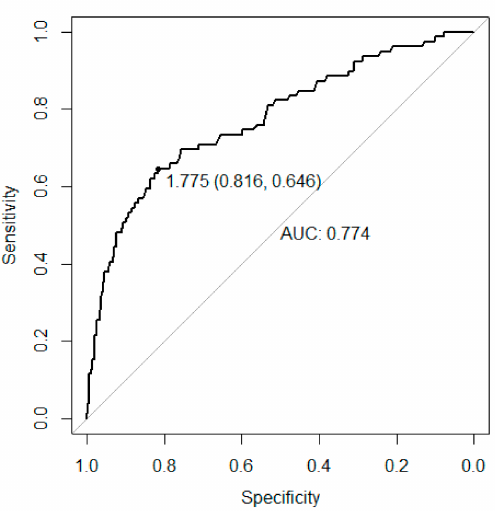
Figure 1. Receiver operation curve (ROC) analysis to find the optimal Visceral Adiposity Index (VAI) cut-off to identify MetS in the whole